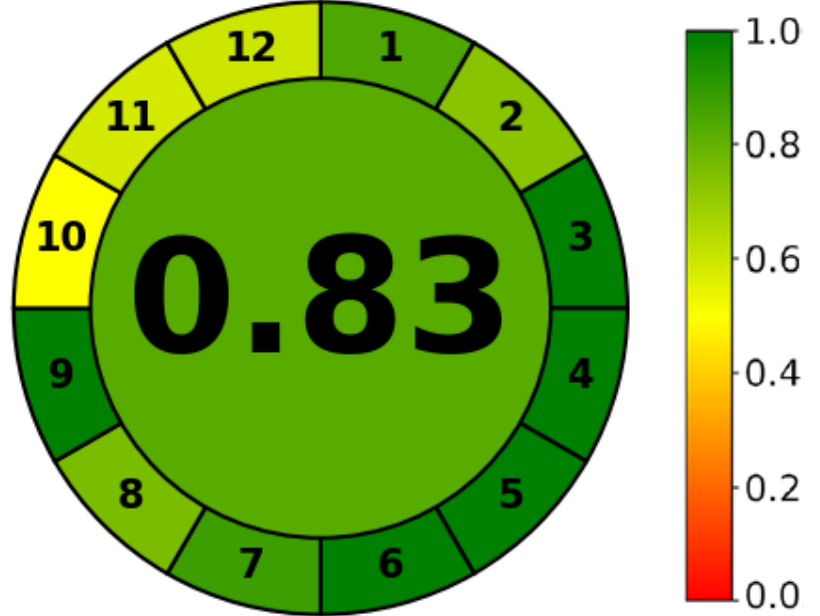
Figure 3. Greenness of the developed method using AGREE software.